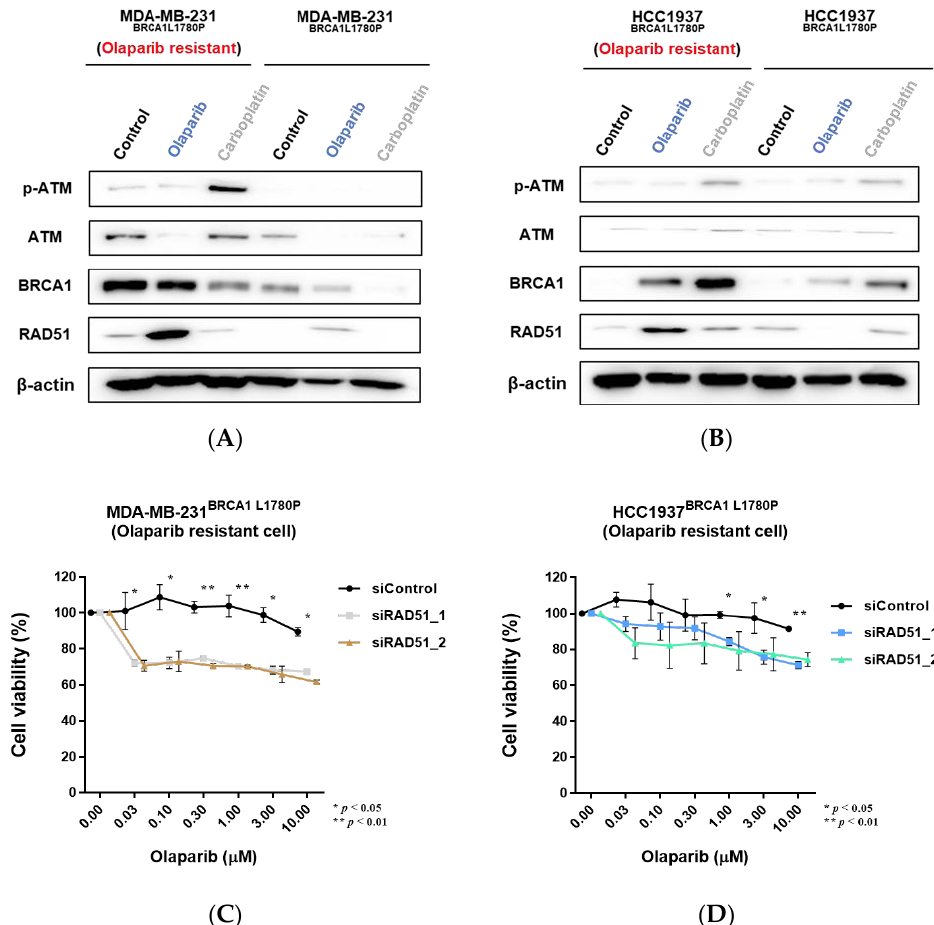
Figure 7. Downregulation of RAD51 expression affects olaparib sensitivity of olaparib-resistant cells. ( A , B ) Upregulation of RAD51 expression affects olaparib resistance in BRCA1 L1780P mutant cells derived from ( A ) MDA-MB-231 and ( B ) HCC1937 cells. ( C , D ) Knockdown of RAD51 in olaparib-resistant cells restored olaparib sensitivity following olaparib treatment. Olaparib-resistant cells derived from ( C ) MDA-MB-231, and ( D ) HCC1937 cells. Data are reported as the mean ± standard deviation (SD). Statistical analysis was performed using the chi-square test. (* p < 0.05, ** p <